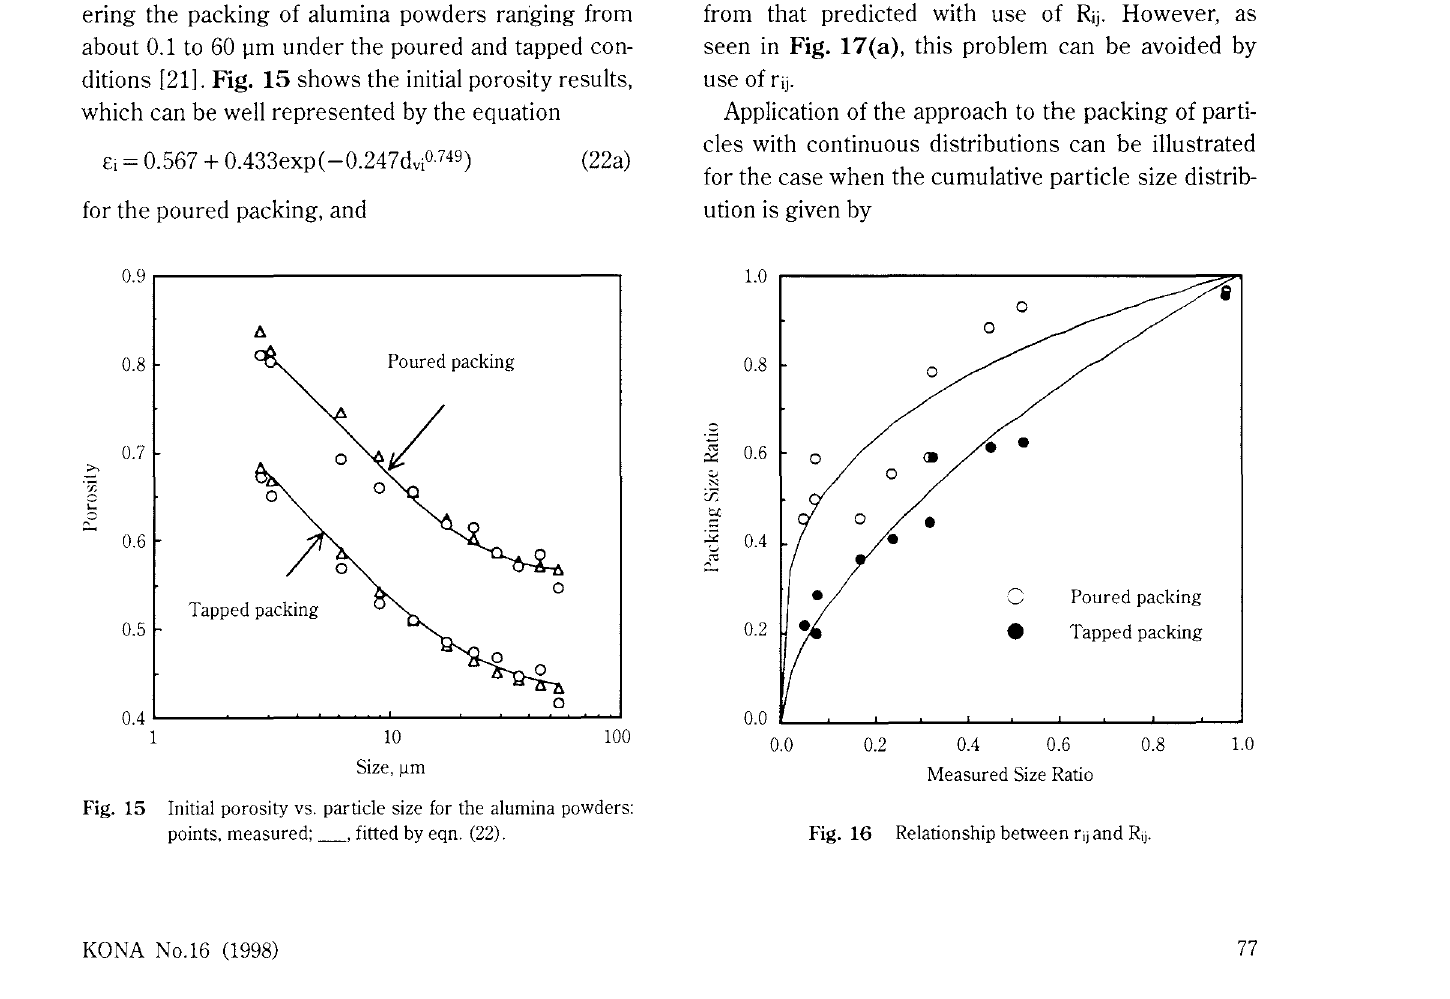
Fig. 15 Initial porosity vs. particle size for the alumina powders: points, measured; _, fitted by eqn. (22). Fig. 16 Relationship between fii and